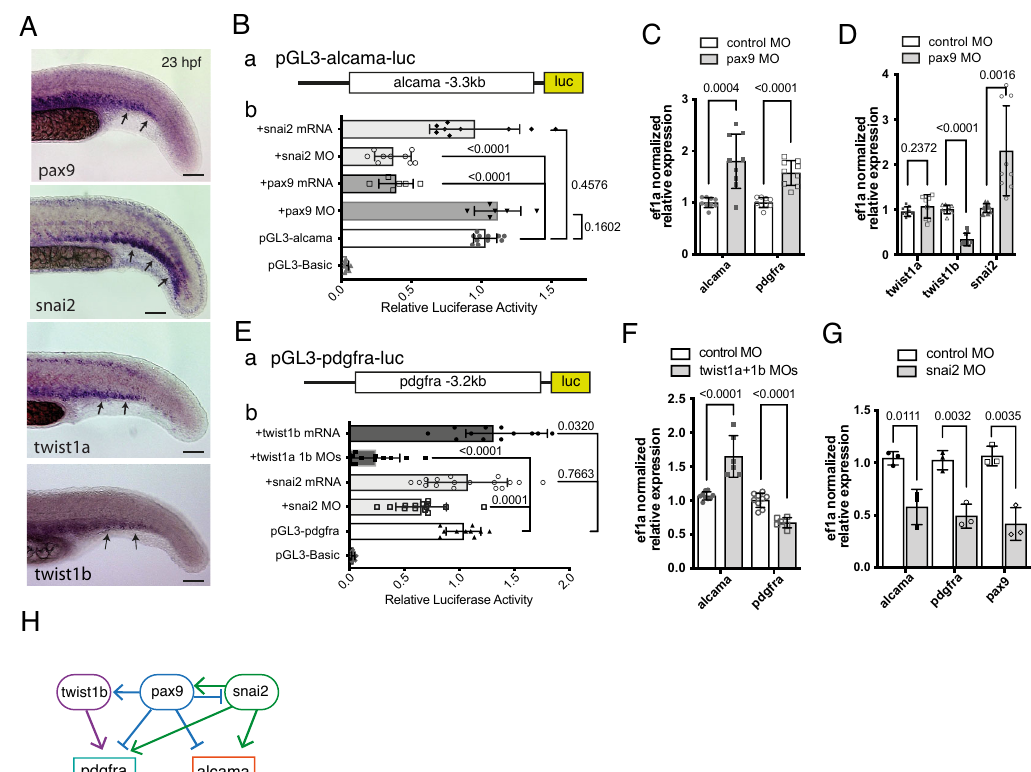
Fig.6| alcama and pdgfra areregulatedbysclerotome-associatedTFs.A WISH for pax9 , snail2 , twist1a , and twist1b at 23 hpf in the tail of WT embryos. Arrows point to expression of these genes in the somitic VCs. B (a ) a DNA fragment encompassing 3.3kb upstream of the alcama gene transcription start site was inserted upstream of the luciferase (luc) coding region ofthe pGL3-Basic plasmid, to give pGL3-alcama-luc. b In situ luciferase assays at 23 hpf following pGL3- alcama-luc injection at the 1-cell stage either alone or together with the indicated mRNA or MO; each lysate was obtained from 10 to 15 tails ( n =9 lysates for each condition, as biological triplicates from three independent experiments) or pax9 ( n =6foreach).ThepGL3-BasicandpGL3-alcama-luc( n =11foreach)wereusedas negative and positive controls, respectively(mean±SD;one-wayANOVAfollowed by Dunnett ’ s multiple comparison test). C qPCR analysis for alcama and pdgfra in pax9morphantsand control( n =9pooledtailsamplesforeach, asetofbiological triplicates from three independent experiments) at 23 hpf. mean±SD; two-tailed Student ’ s t -test. D qPCR analysis for twist1a , twist1b , and snai2 in pax9 morphants and control ( n =9 pooled tail samples for each, measured examined over three (Fig. 7B, C-a, D-a; Supplementary Movie 8). Time-lapse confocal ima-